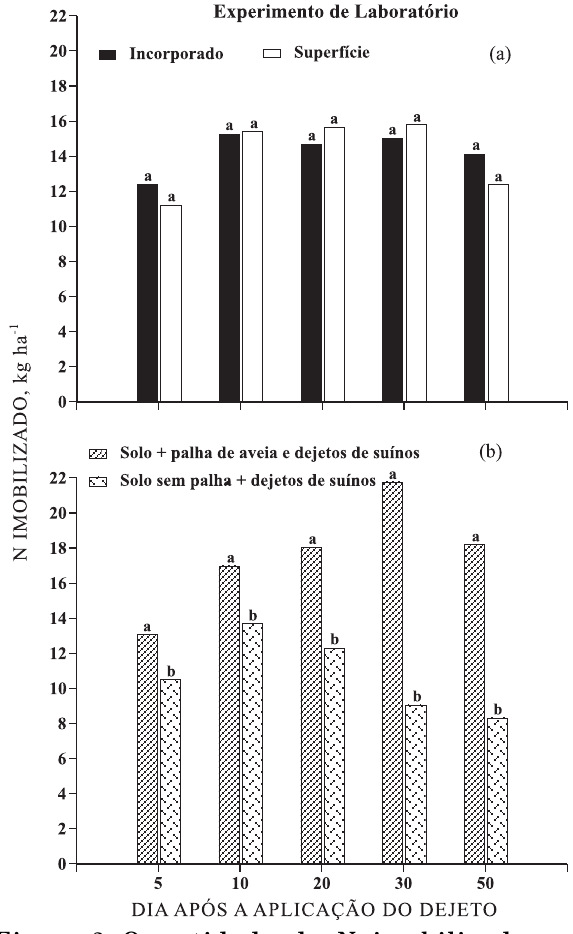
Figura 3. Quantidade de N imobilizado em laboratório, derivado do N amoniacal aplicado com os dejetos líquidos de suínos na superfície ou incorporados ao solo (a), com ou sem palha de aveia (b). Valores seguidos da mesma letra em cada data de avaliação não apresentam diferenças significativas entre si pelo teste de Tukey, a